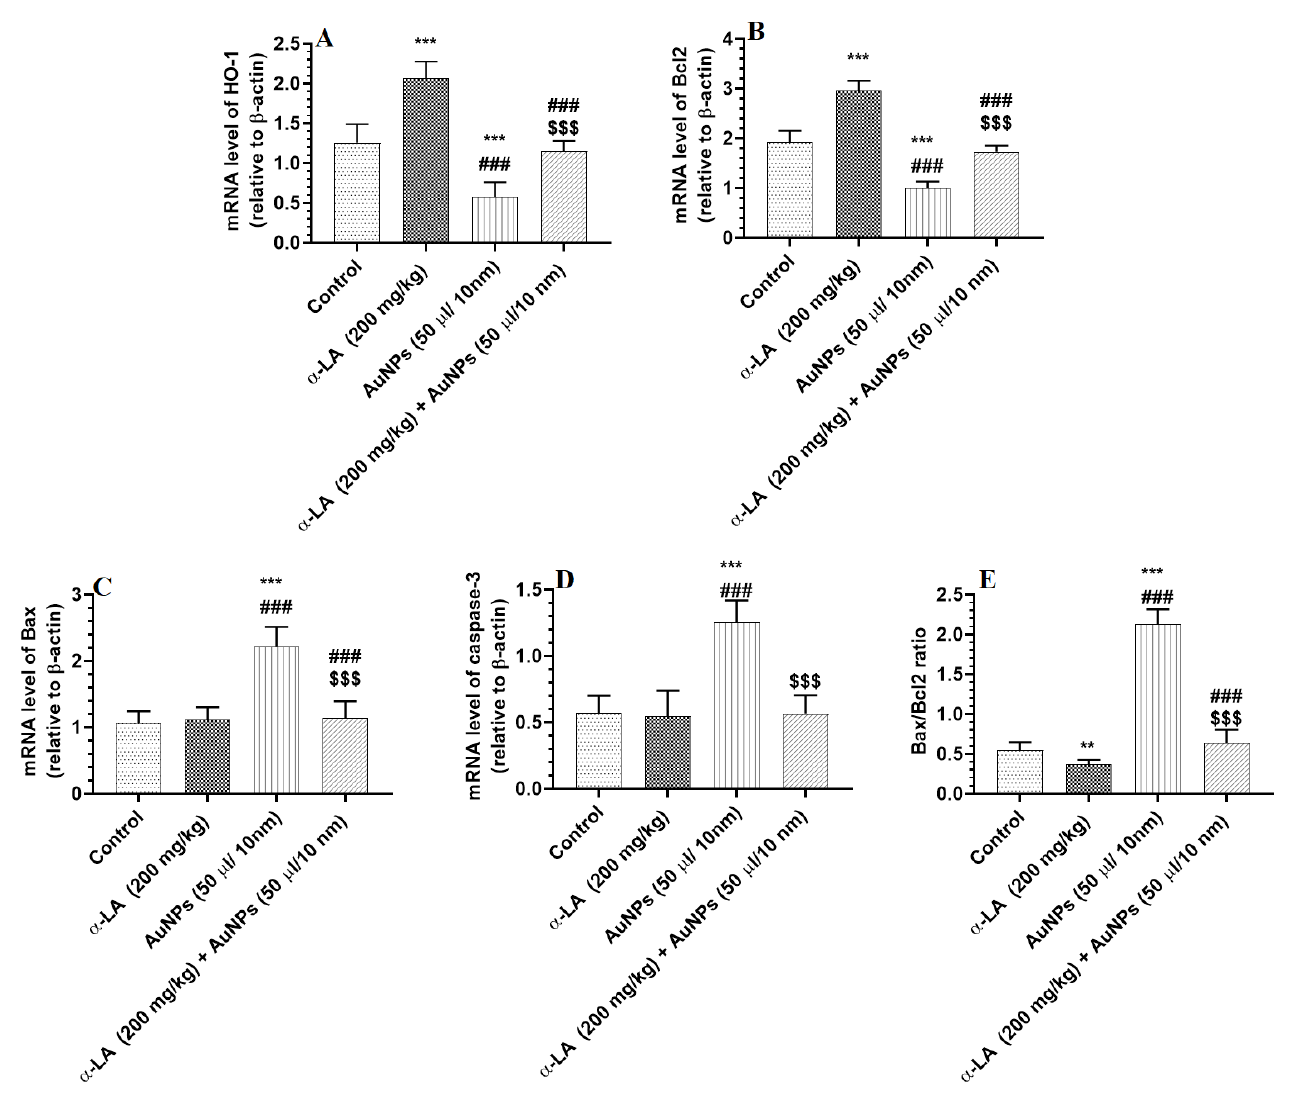
Figure 6. α -lipoic acid (LA) stimulates the transcription of heme-oxygenase-1 (HO-1) ( A ) and Bcl2 ( B ) in the livers of control and gold nanoparticles (AUNPs)-treated rats but suppresses the transcription of Bax ( C ) and caspase-3 ( D ), only, in the livers of AuNPs-treated rats. ( E ): represents the ratio of mRNA levels of Bax to mRNA of Bcl2. Bcl2: an anti-apoptotic protein. Bax and cleaved caspase-3 are Apoptotic proteins. All transcriptions were performed by qPCR. Data were given as means ± SD (n = 8/group). p < 0.05. **, ***: vs. control at p < 0.001, and 0.0001, respectively; ###: vs . α -LA at p < 0.0001, respectively; and $$$: vs. AuNPs at p < 0.0001.